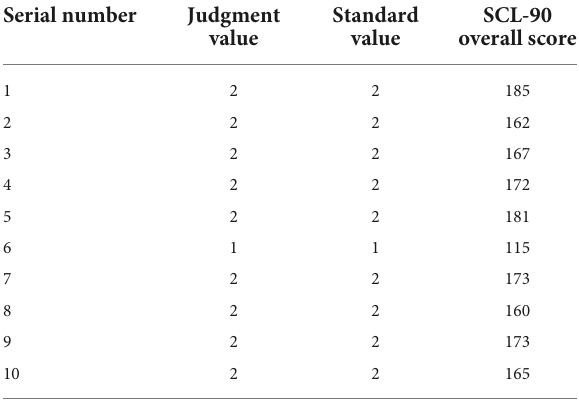
TABLE 4 Comparison results of